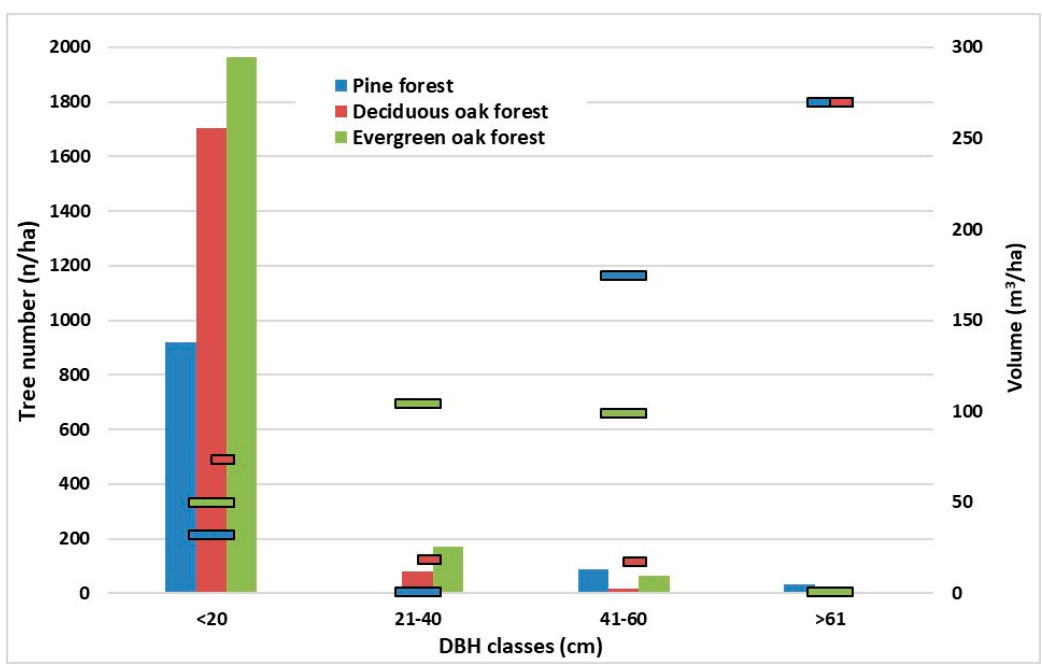
Figure 2. The histograms show the number of living trees referred to diameter (DBH) distribution in each forest types (left y-axis) . The scatter bars show the living trees volume per DBH class (right y-axis).